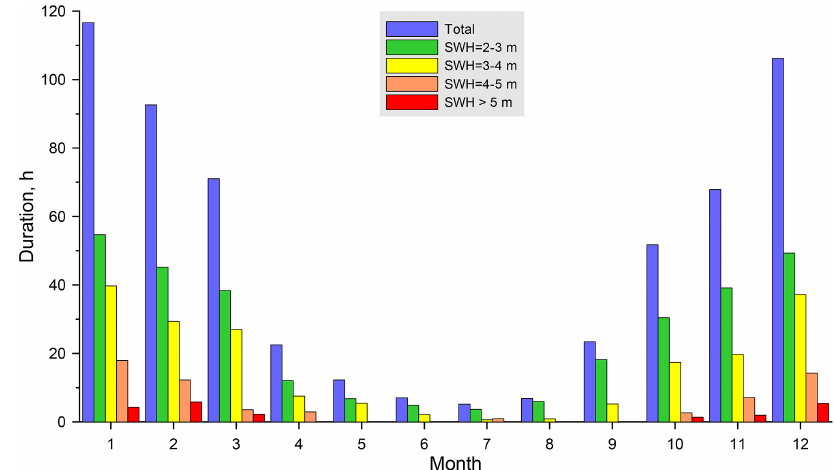
Figure 27. Average duration of storms per month (total and wave height